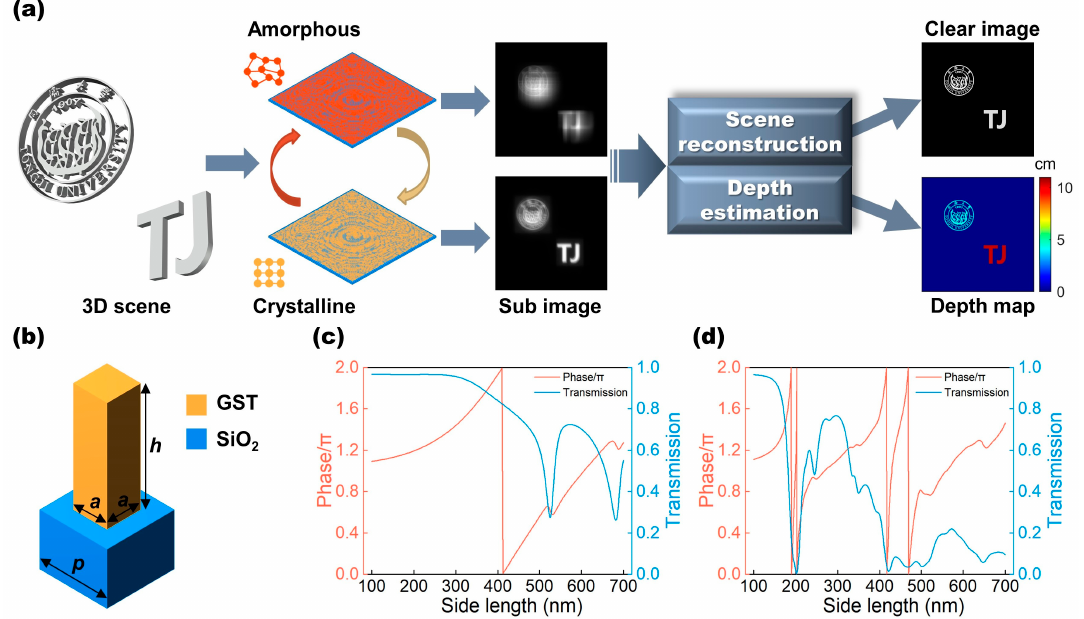
Figure 1. ( a ) Schematic diagram of working principle of the bifunctional metalens. ( b ) Schematic view of the unit cell, consisting of GST nanorod and silica base. The geometric parameters include side length 𝑎 , period 𝑝 , and height ℎ . In ( c , d ), the phase and transmission of C-state and A-state GST nanorods are shown as a function of side length 𝑎 , respectively.